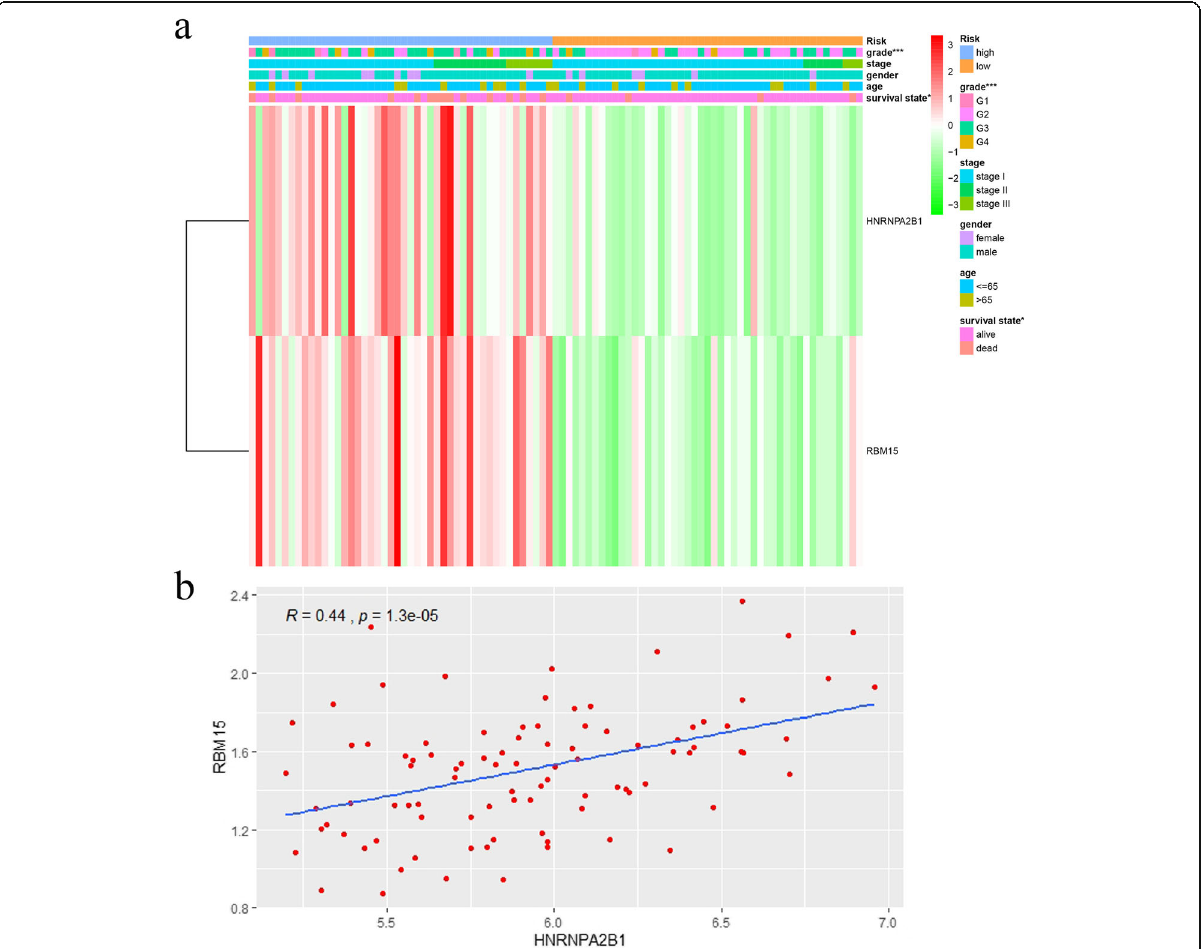
Fig. 5 a Heatmap of RBM15 and HNRNPA2B1 expression; correlation between expression and clinical information in the high-risk and low-risk groups. “ * ” represents statistical significance at P < 0.05, “ ** ” represents statistical significance at P < 0.01, “ *** ” represents statistical significance at P < 0.001. b Correlation analysis between RBM15 and